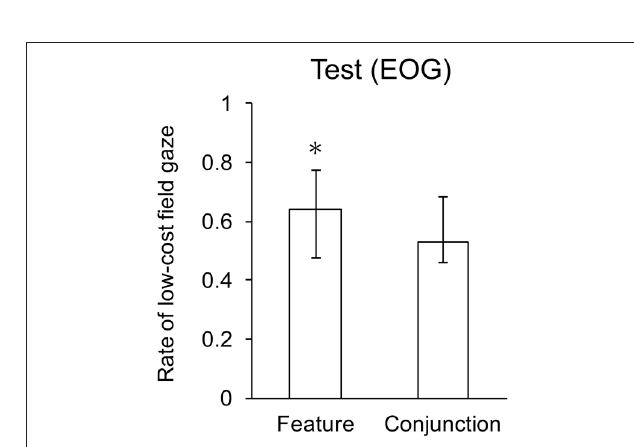
FIGURE 6 | Mean gaze rates to the low search cost field. Whiskers indicate one standard deviation, and * indicates means significantly lower than